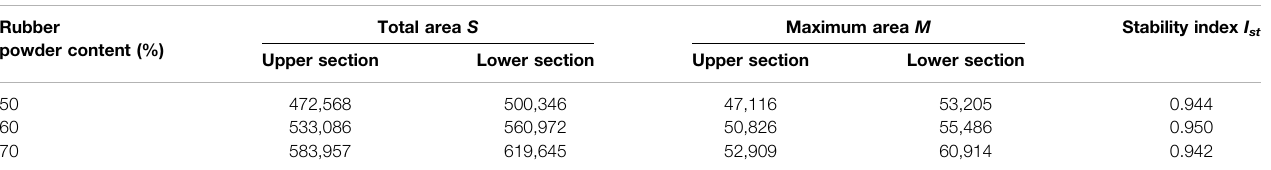
TABLE 3 | Stability index of various modi fi ed asphalts ( I st